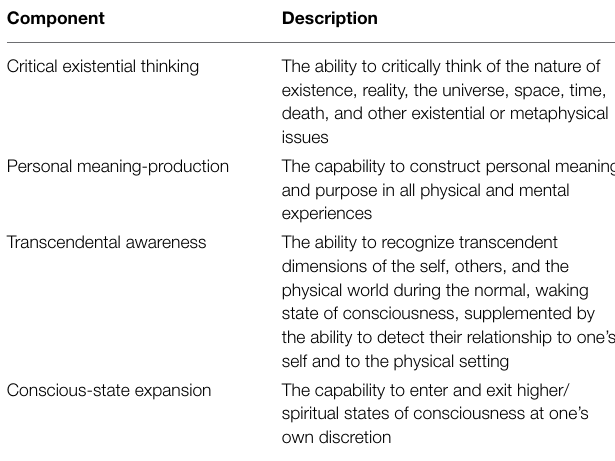
TABLE 1 | Different components of